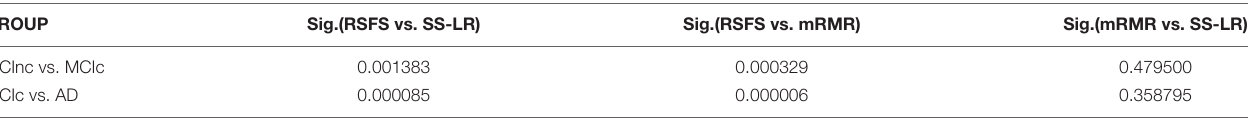
TABLE 3 | Comparison of classification results between different feature selection methods.